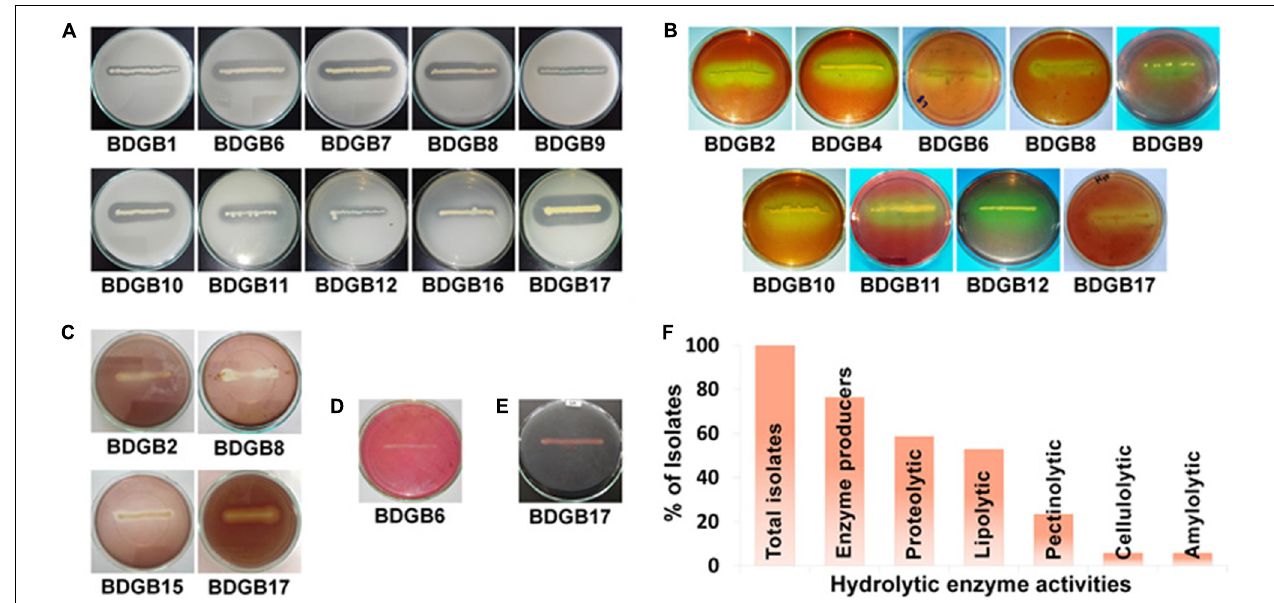
FIGURE 1 | Production of extracellular hydrolytic enzymes by the gut-associated bacteria of Bombay duck. Plate assay showing (A) proteolytic, (B) lipolytic, (C) pectinolytic, (D) cellulolytic and (E) amylolytic enzyme activities of the isolated bacteria. The assay was performed by inoculation of the bacterial isolates on agar media containing suitable substrate specific for each enzyme activity. After incubation at 30 ◦ C for 48 h, media were treated with specific staining solutions to visualize formation of clear halos around bacterial colonies indicating production of the respective enzymes. Isolates that did not produce any halo zone, are not shown. (F) Distribution (%) of extracellular hydrolytic enzyme activities among the isolates.